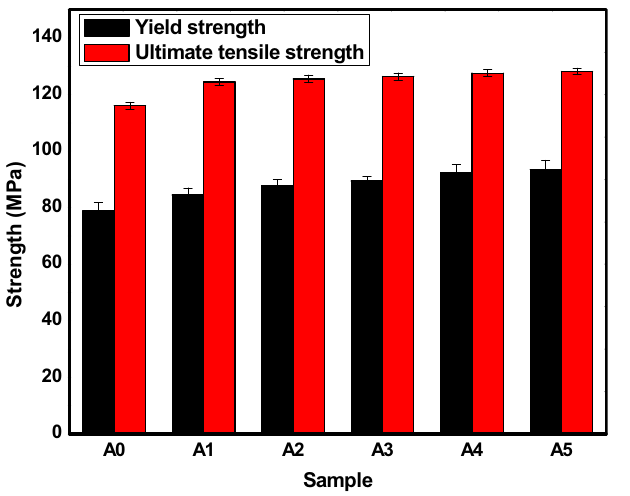
Figure 10. YS and UTS of the composite produced.